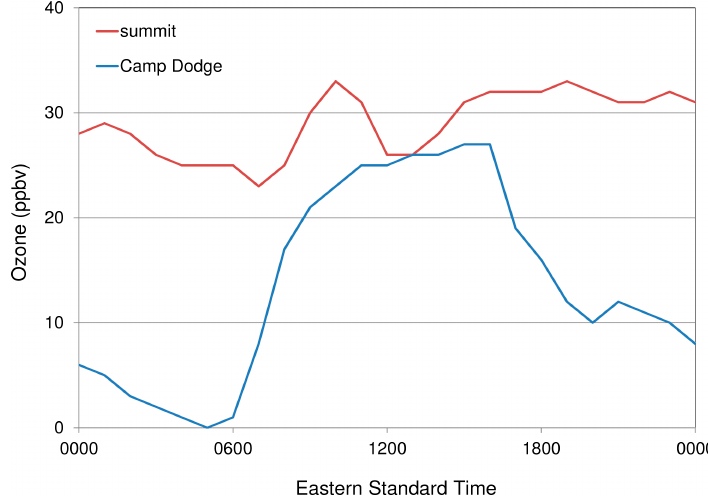
Figure 5. Hourly ozone concentrations (ppb) recorded at the Mount Washington summit (red) and at Camp Dodge (blue), near the base of the mountain on 19 August 2016.